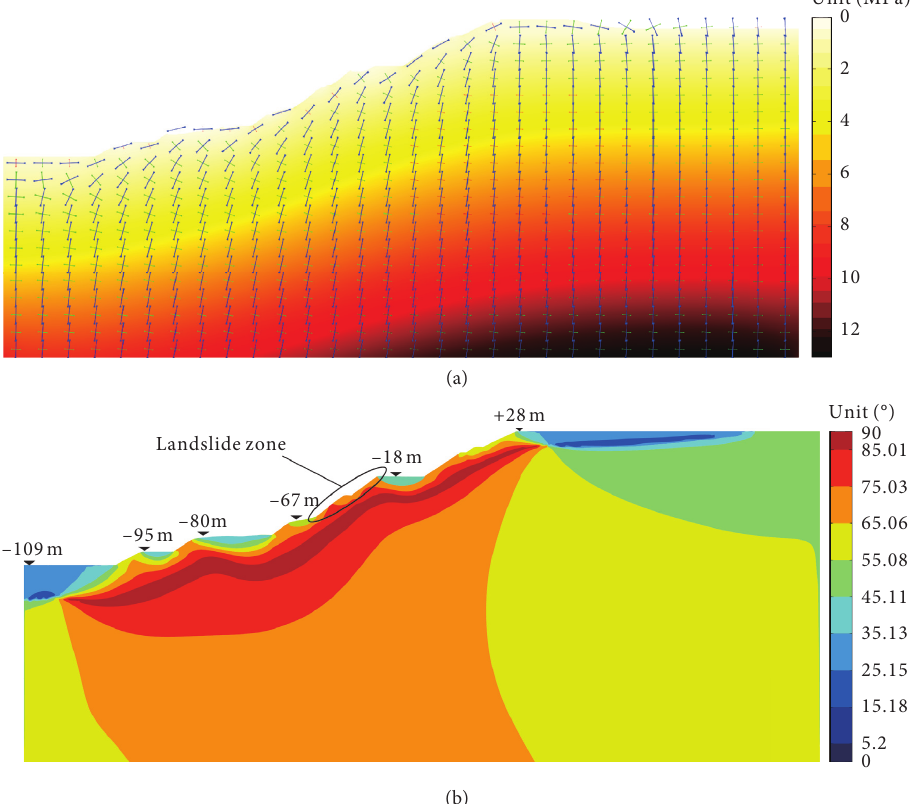
Figure 12: (a) The maximum principal stress distribution on the N26 profile. (b) The angle of ß distribution on the N26 profile.